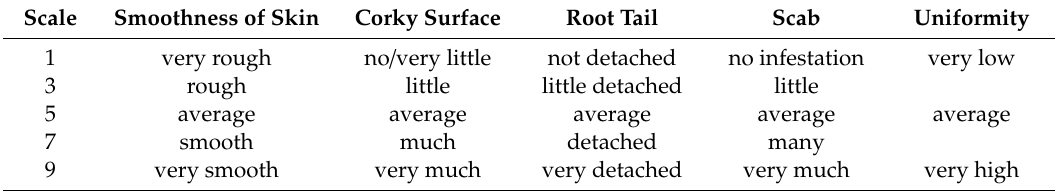
Table 2. Evaluation specification of five important outer traits of beetroot using a 1–9